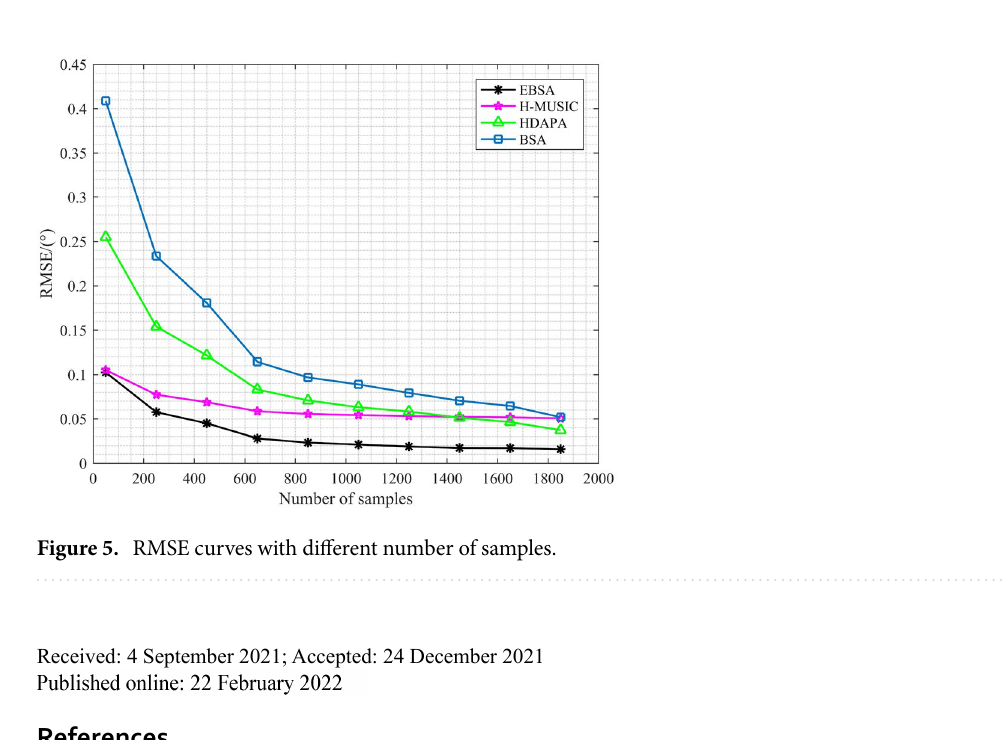
Figure 4. RMSE curves with different SNR .